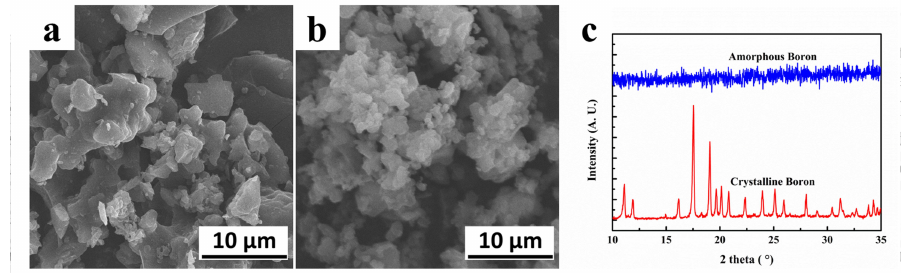
Figure 1. ( a ) SEM secondary electron image of crystalline boron (C-B) powder; ( b ) SEM secondary electron image of amorphous boron (A-B) powder; ( c ) XRD patterns of C-B and A-B powders.